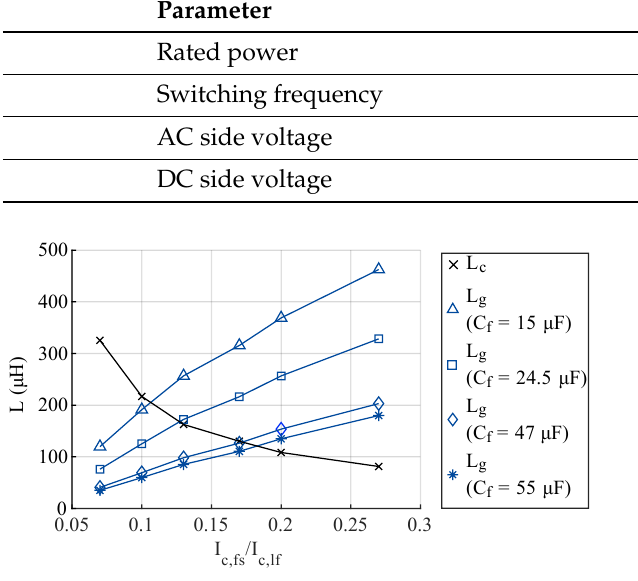
Figure 3. Inductance of L c and L g as a function of I c , f